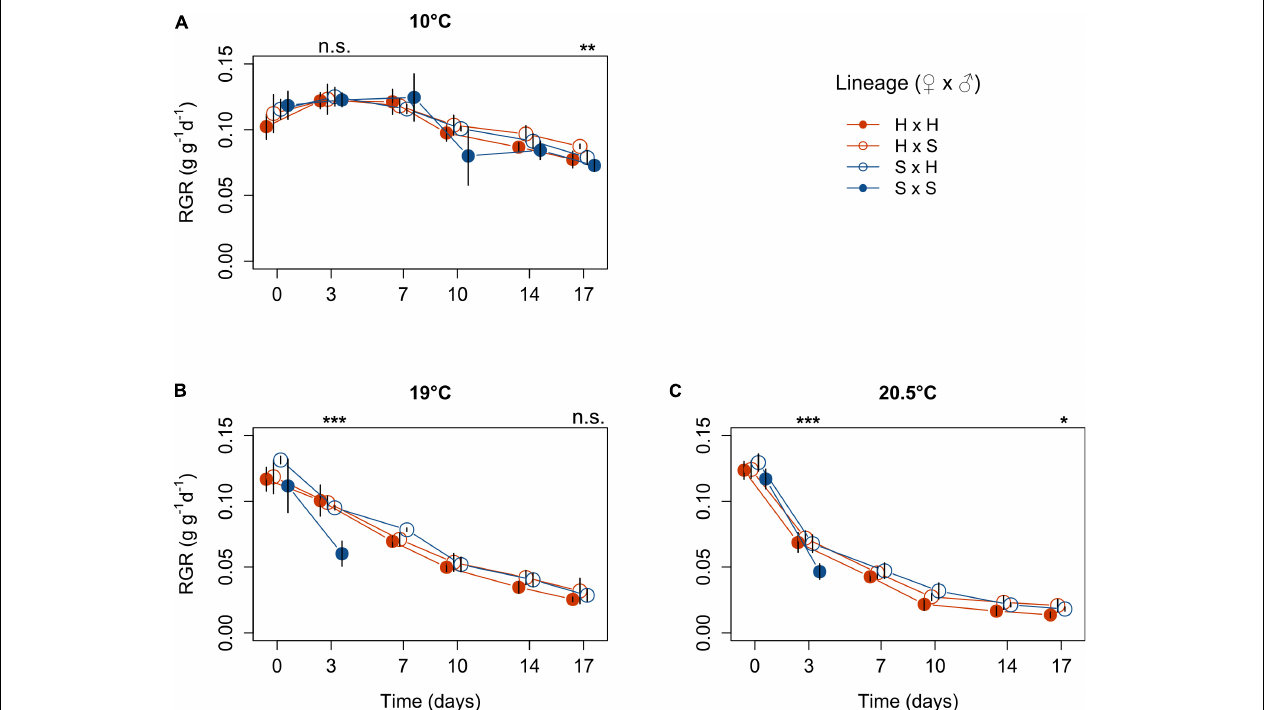
FIGURE 2 | Relative growth rates of Laminaria digitata macroscopic sporophytes produced by crossing females × males from Helgoland (H) and Spitsbergen (S) over time at 10 ◦ C (A) , 19 ◦ C (B) and 20.5 ◦ C (C) in experiment 2 (mean ± SD, n = 4). Significance of the fixed effect lineage on sporophyte growth after 3 and 17 days of temperature exposure is indicated above each panel (ANOVA; ***, p < 0.001; **, p < 0.01; *, p < 0.05; n.s., not significant). For pairwise comparisons, see main text. TABLE 2 | Results of linear models to examine relative growth rates among lineages for two time points in the critical heat stress experiment on macroscopic Laminaria digitata sporophytes (experiment 2). Day 3 Day 17 Temp. ( ◦